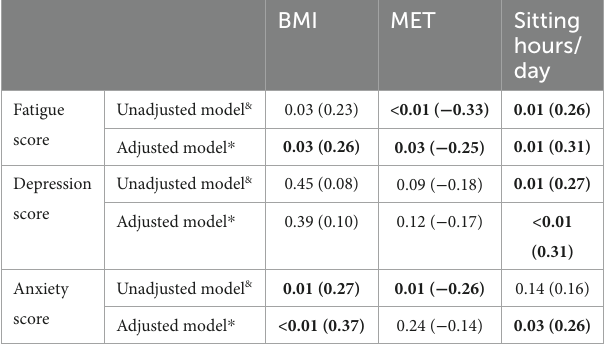
TABLE 3 The correlation of body mass index, physical activity, and sitting hours per day with fatigue, depression, and anxiety.